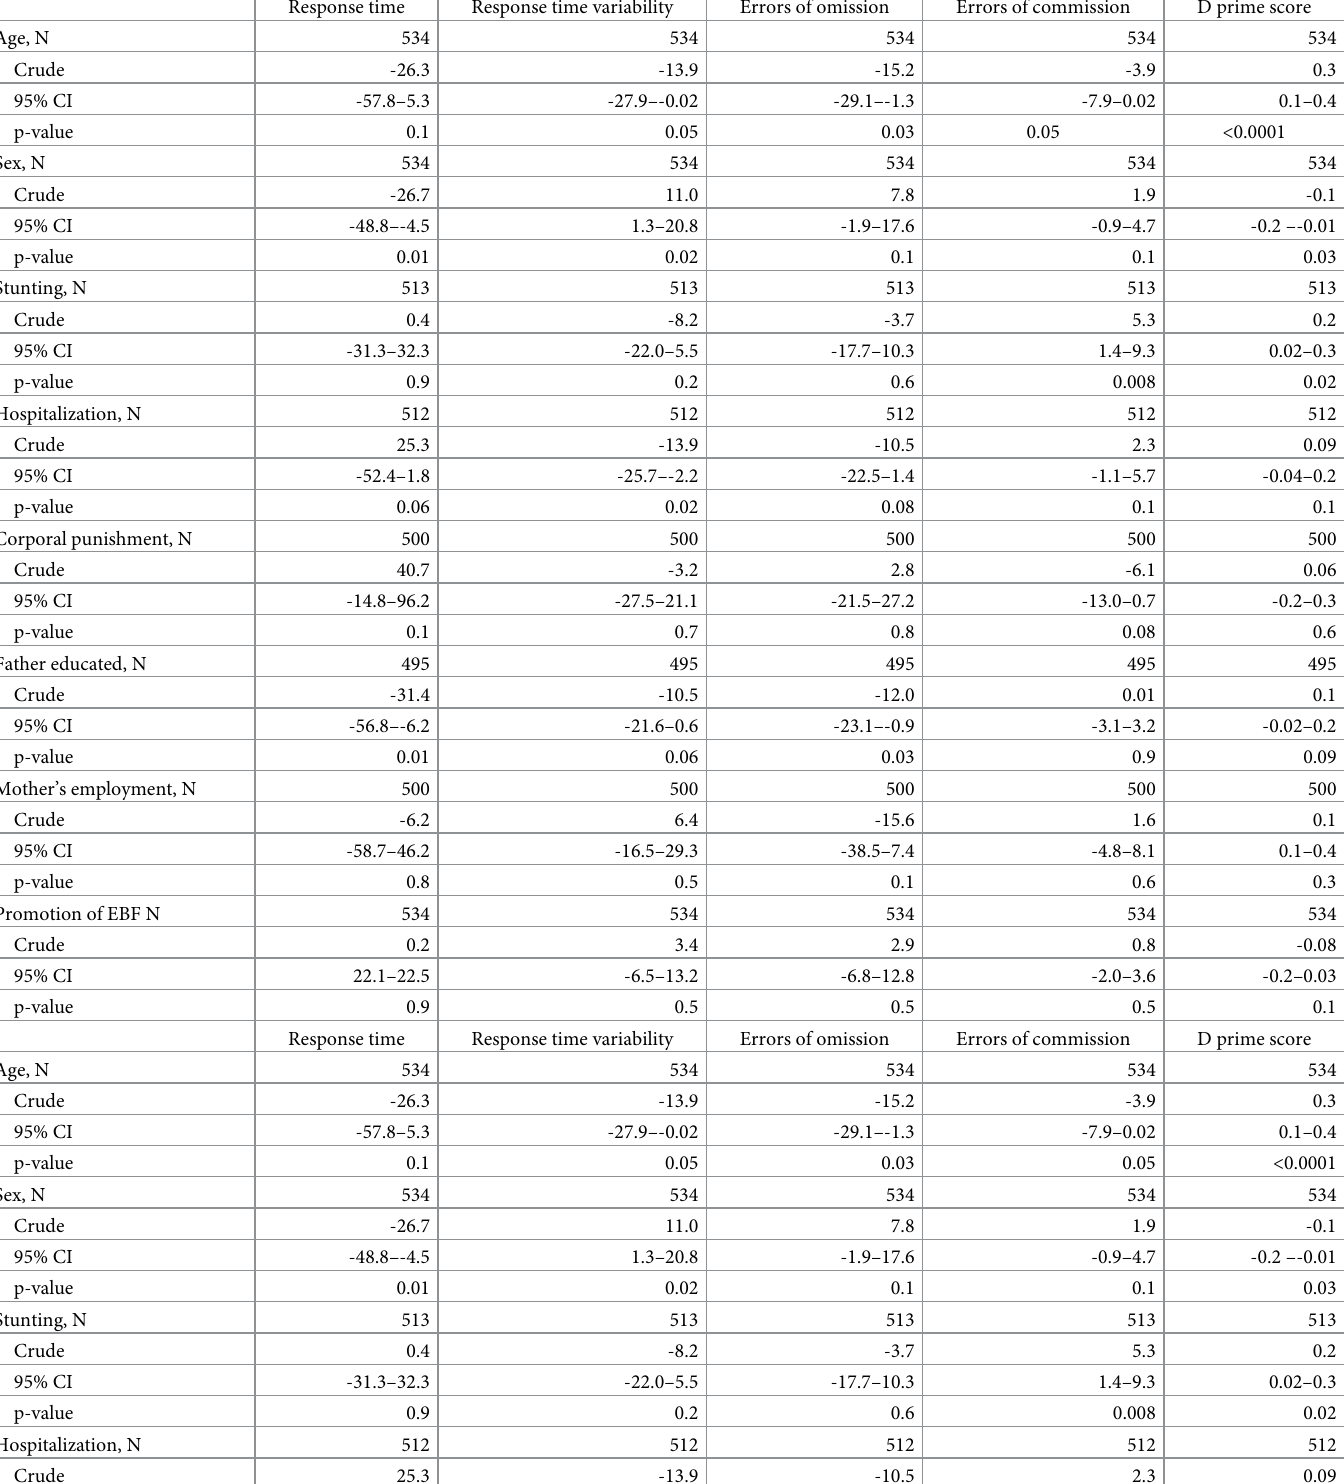
Table 6. Crude coefficient between covariates and the TOVA among children from the PROMISE Saving Brains study in rural Burkina Faso. Response